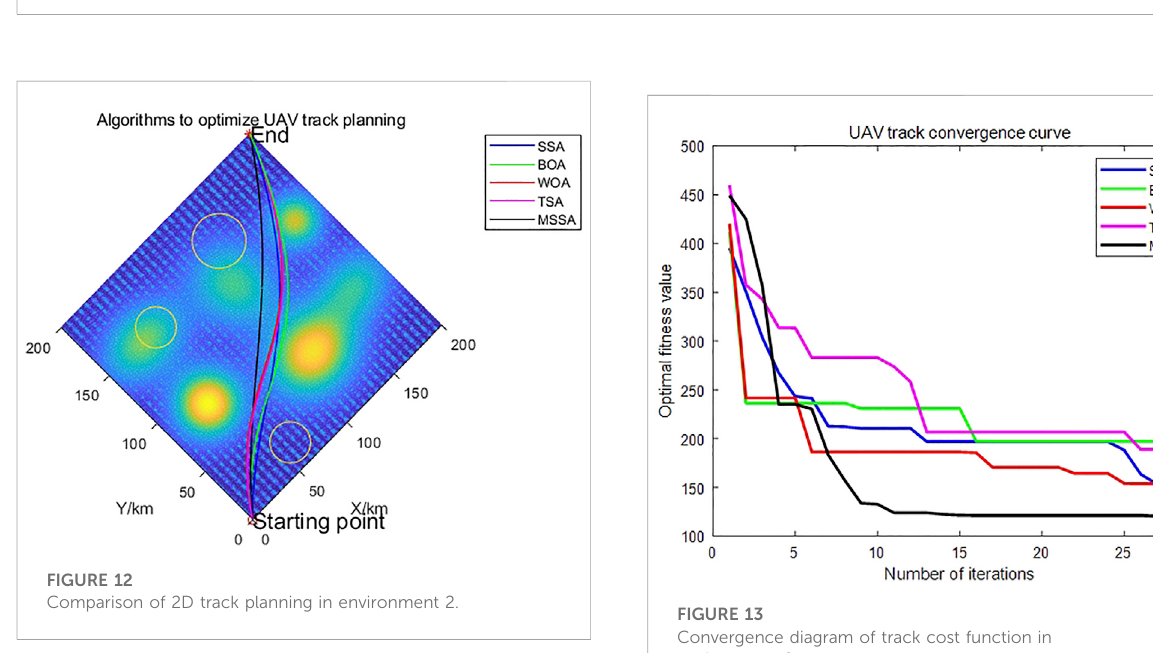
FIGURE 11 Simulation results of 3D trajectory planning in environment 2 from two different views.